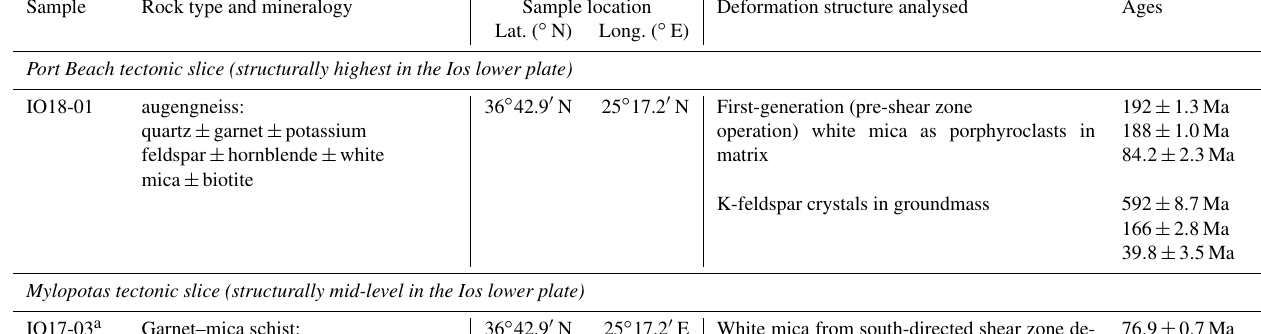
Table 2. List of